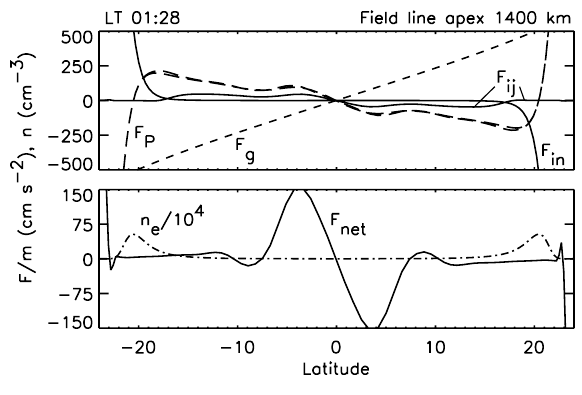
Fig. 3. Top panel: field-aligned forces, gravity (dashed line), ion and electron pressures (long-dashed lines), and diffusion ( F in , F ij , solid lines), acting on O + ions are indicated for a field line corre- sponding to the ionization crests within the plume. Bottom panel: net field-aligned force (solid line) acting on O + ions is plotted. Electron density (dot-dash) is also